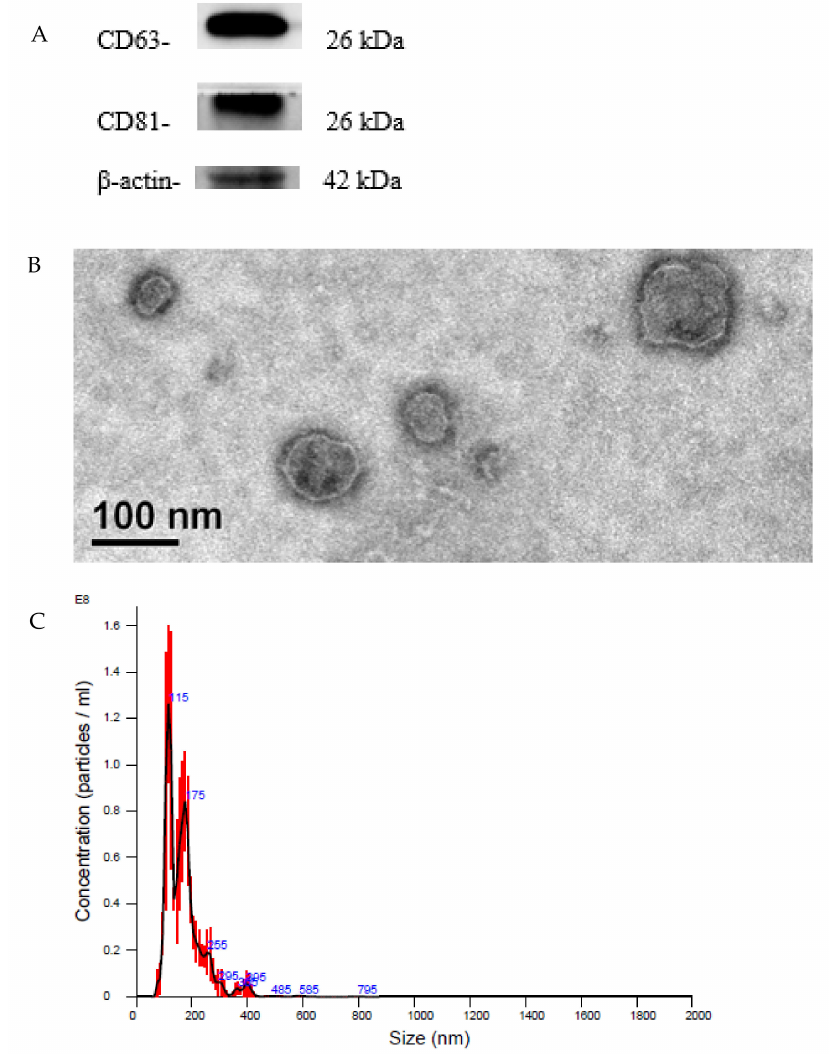
Figure 2. Characteristic proteins of SCAP-isolated exosomes ( A ). Morphology of SCAP-ex under TEM ( B ). Size distribution of SCAP-ex by NTA ( C ). NTA, nanoparticle tracking analysis; SCAPs, stem cells from the apical papilla; SCAP-ex, SCAP-derived exosomes; TEM, transmission electron